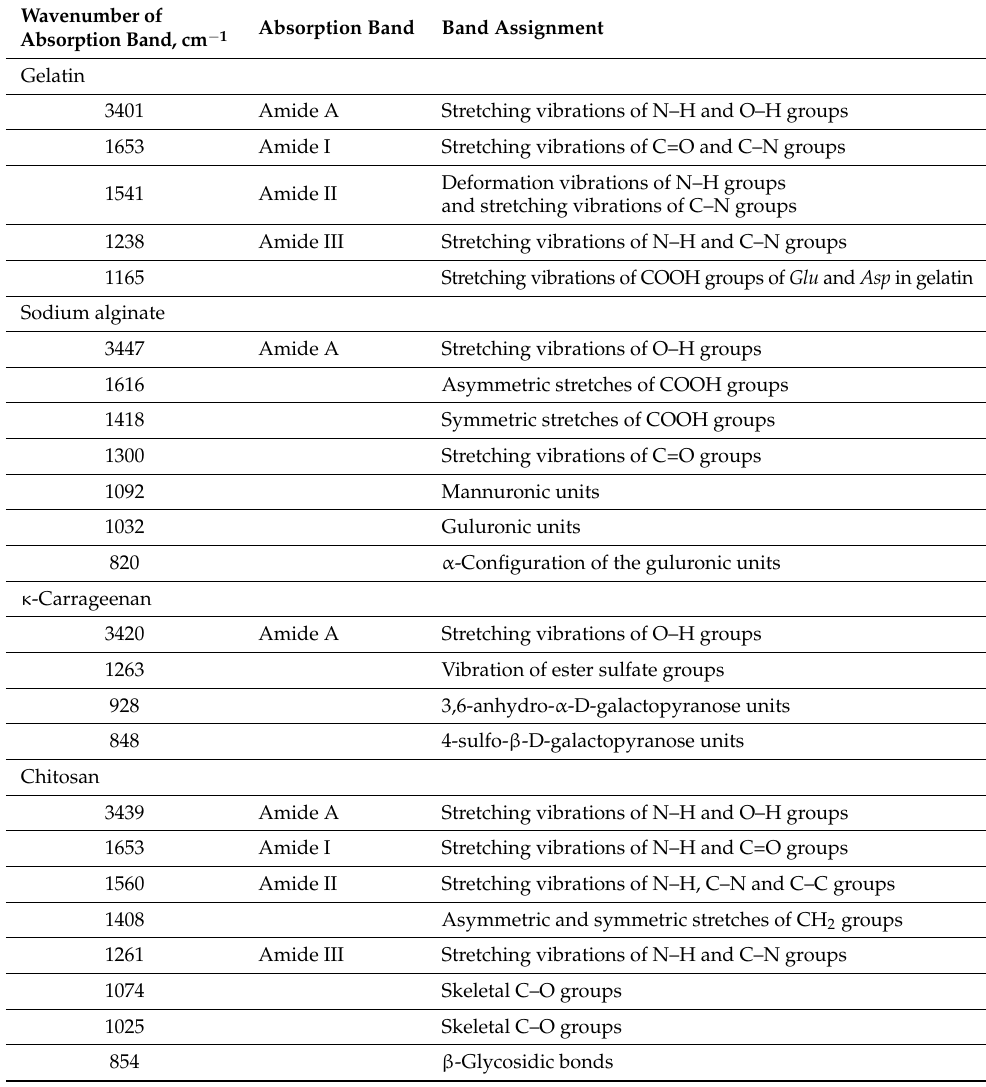
Table 3. Location and assignment of the peaks identified in the FT-IR spectra of